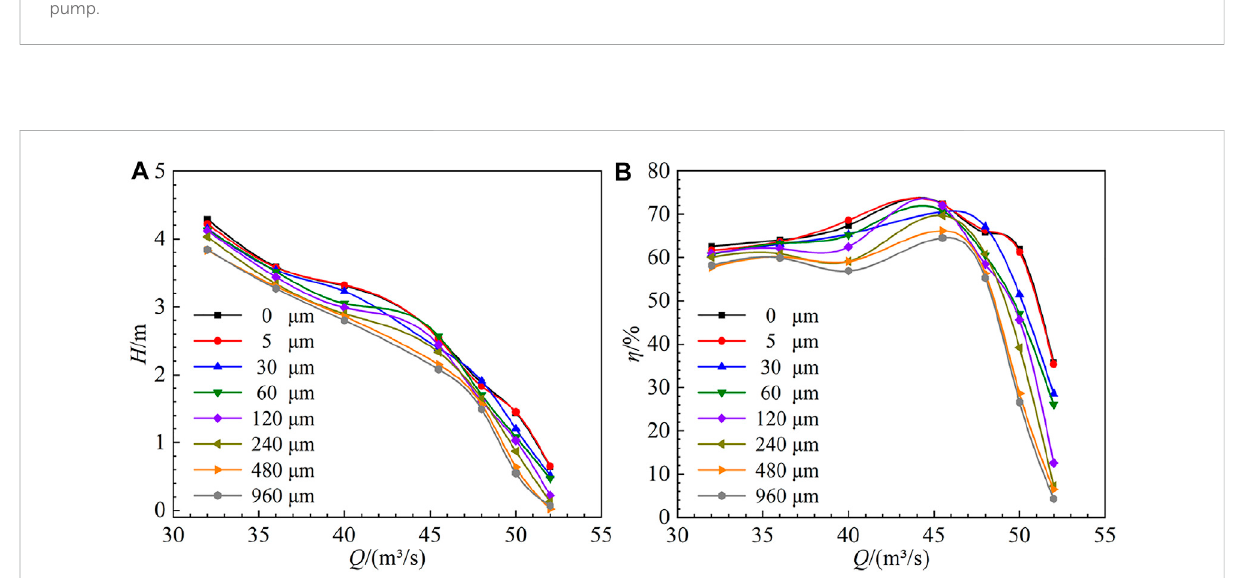
FIGURE 9 Head and ef fi ciency of IR pumps with different roughness values: (A) H versus Q and (B) η versus Q